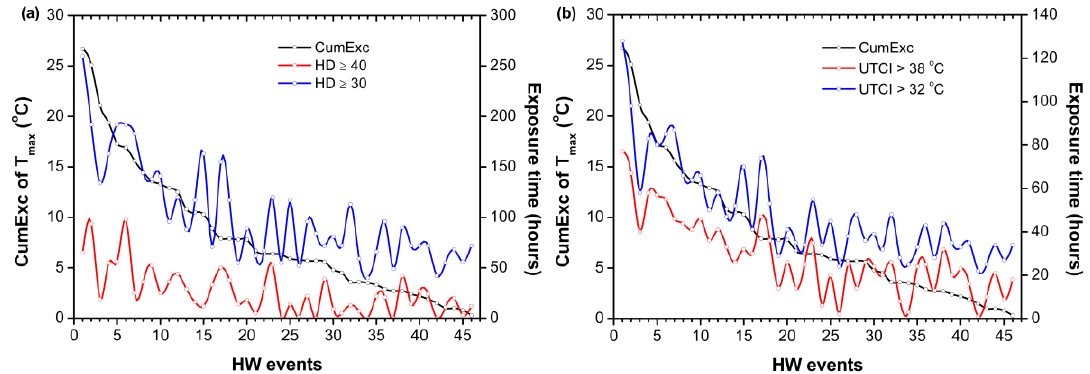
Figure 6. Time in hours when people are exposed to ( a ) HD ≥ 30, HD ≥ 40; and ( b ) UTCI > 32 °C, UTCI > 38 °C for each of the 46 HW events of the 1960 – 2017 period, organized in descending order of T max cumulative exceedance (CumExc).